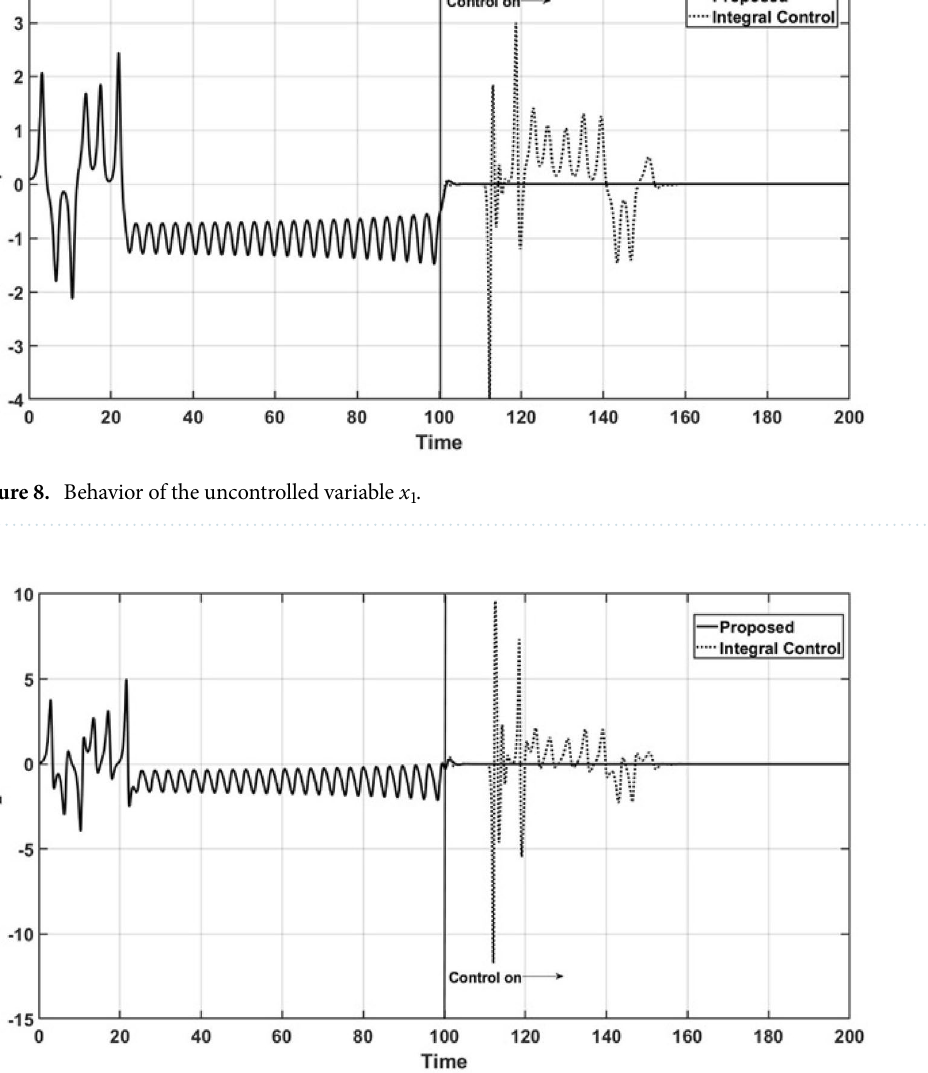
Figure 9. Behavior of the uncontrolled variable x 2